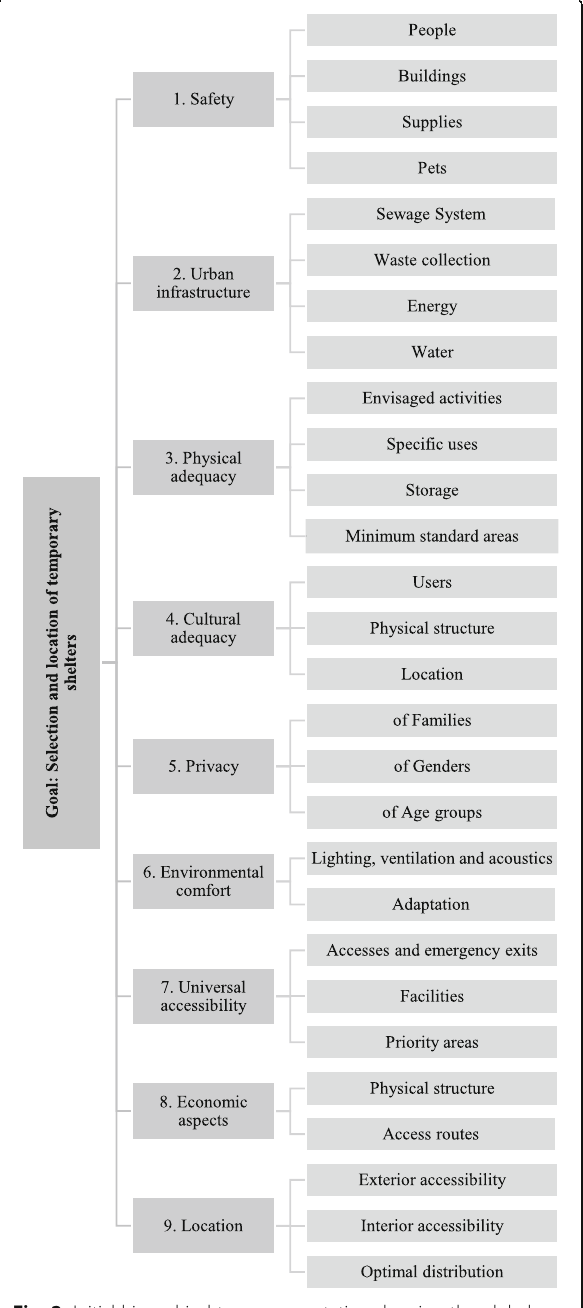
Fig. 2. Initial hierarchical tree representation showing the global and local